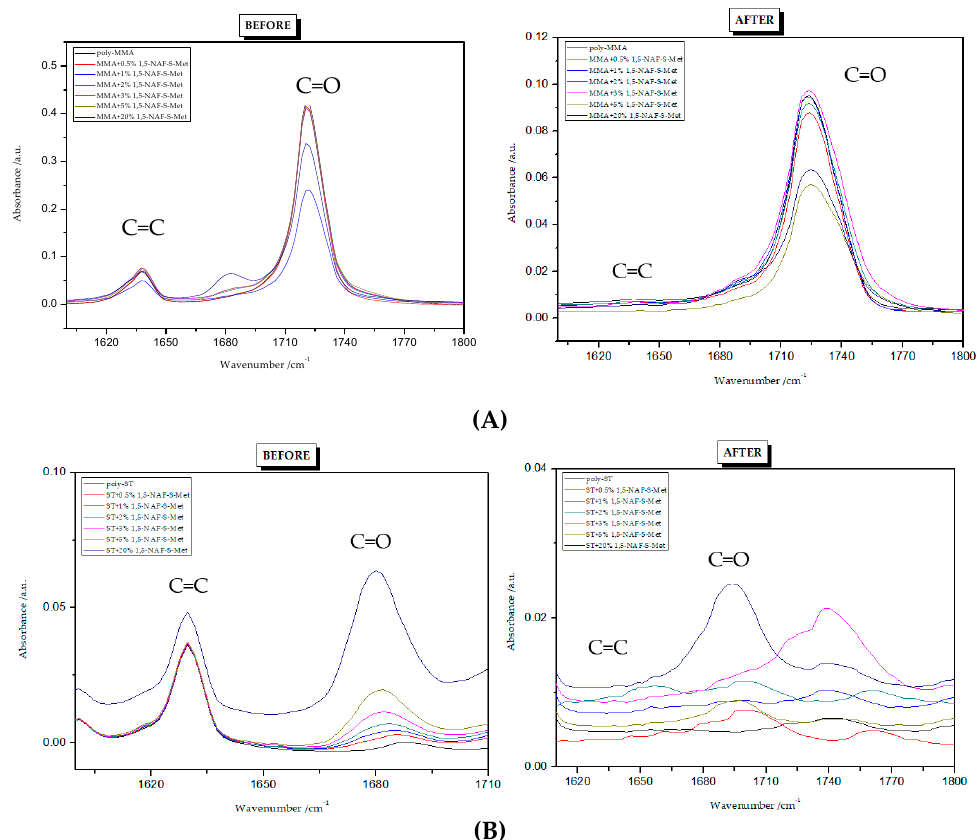
Figure 5. FTIR spectra of 1,5-NAF-S-Met polymers: ( A ) copolymers with MMA; ( B ) copolymers with ST.